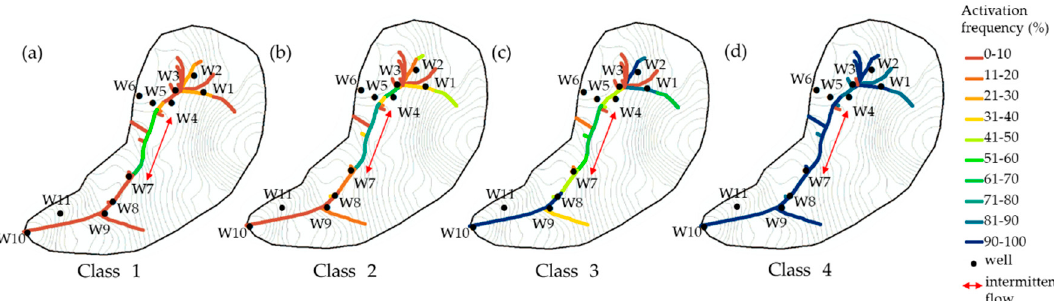
Figure 8. Channel activation frequency for each event class and location of each well. ( a ) Class 1. ( b ) Class 2. ( c ) Class 3. ( d ) Class 4. Each separate colored channel section indicate the position of an overland-flow detector. The arrow indicates the length of intermittent flow section.